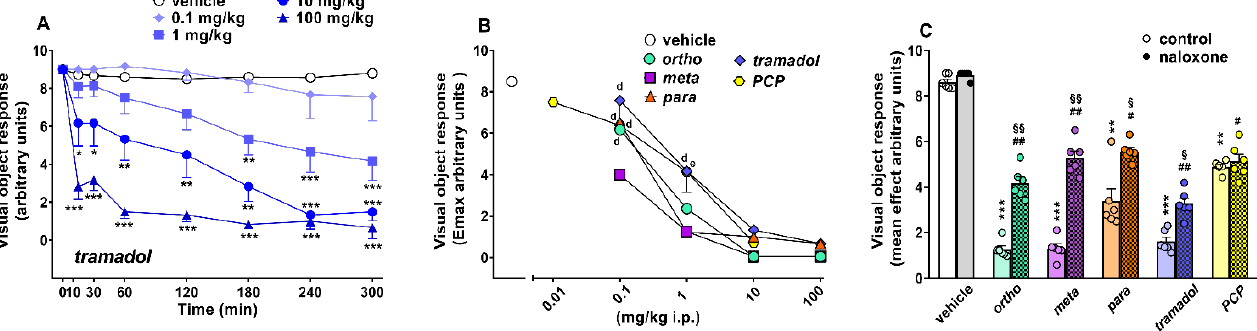
Figure 3. Effect of the systemic administration of tramadol (0.1–100 mg/kg i.p.; ( A )) on the visual object test in mice. Comparison of the maximal effect of ortho, meta, para, tramadol (0.1–100 mg/kg) and PCP (0.01–10 mg/kg) observed in 5 h ( B ) 1,2 . Interaction of the maximal effective dose of ortho, meta, para, tramadol (100 mg/kg) and PCP (10 mg/kg) with the opioid receptor antagonist naloxone (6 mg/kg, i.p.; ( C )). Data are expressed as arbitrary units and represent the mean ± SEM of 6–8 determinations for each treatment. Statistical analysis was performed by two-way ANOVA, followed by the Bonferroni’s test for multiple comparisons for the dose–response curve of each compound at different times ( A ), and for the antagonist studies ( C ), while the statistical analysis of ( B ) was performed with one-way ANOVA followed by Bonferroni test for multiple comparisons. * p < 0.05, ** p < 0.01, *** p < 0.001 versus vehicle; d p < 0.05 versus meta; e p < 0.05 versus para; # p < 0.05, ## p < 0.01 versus naloxone; § p < 0.05, §§ p < 0.01 versus without naloxone. 1 ortho, meta and para data are elaborated from [5]; 2 PCP data are elaborated from [17].